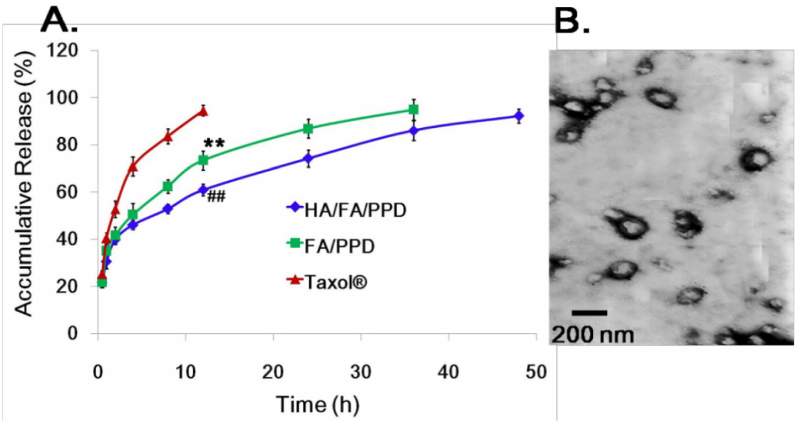
Figure 5. In vitro release study. ( A ) In vitro release of PTX from HA/FA/PPD, FA/PPD and Taxol ® ; ( B ) TEM morphology of HA/FA/PPD after 12 h incubation in the release media ( n = 3). ** p < 0.01, statistically significant difference between Taxol ® and FA/PPD; ## p < 0.01, statistically significant difference between Taxol ® and